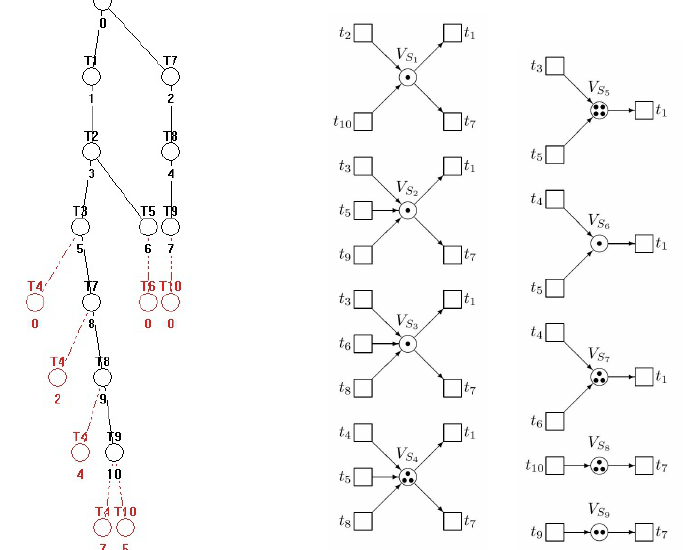
Figure 13. The RT of the controlled PN model ( left ). No deadlocks are there. Both of sections (sub-nets) are active. The supervisor consisting of nine monitors ( right